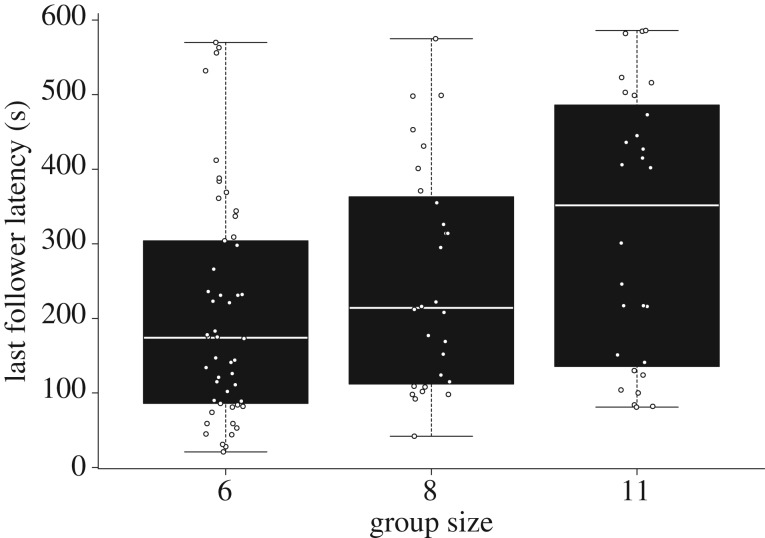
Boxplots with datapoints of joining latencies of the last followers as a function of group size. Group size 6 includes groups B and F. Only movements in which the whole group followed were considered (n = 106 movements; group A = 28, B = 25, F = 25, J = 28).